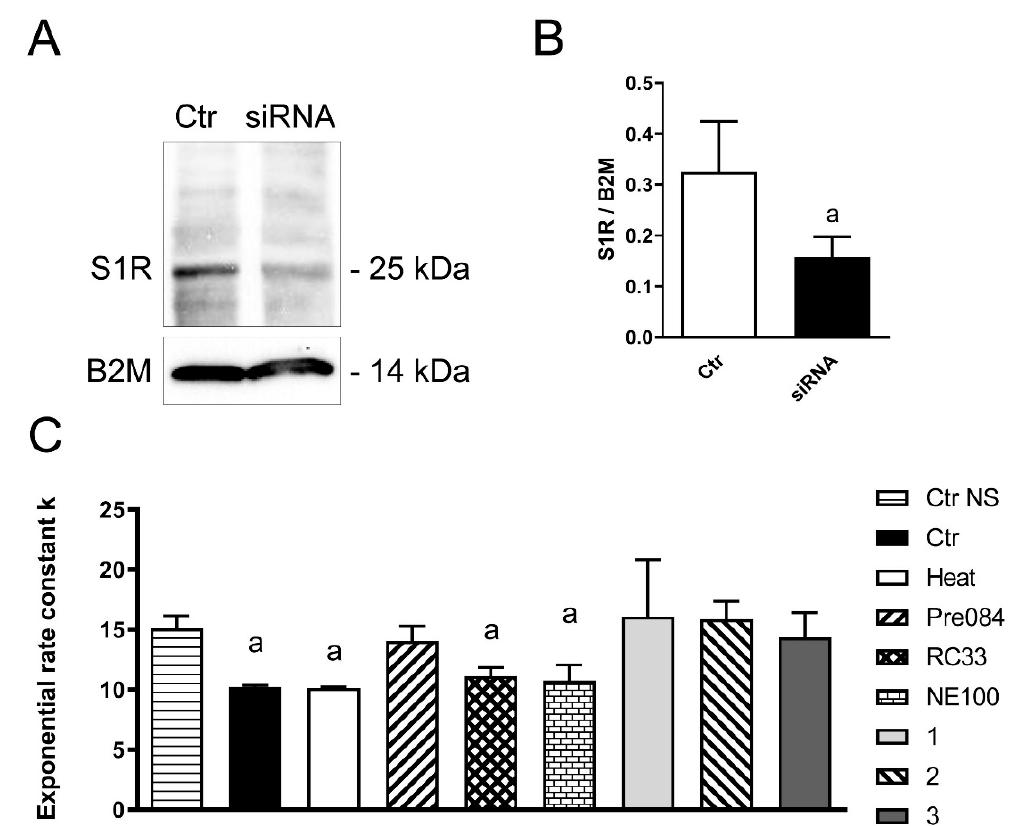
Figure 7. Effect of compounds Pre084, RC33, NE100, 1 – 3 on the water permeability of S1R silenced HeLa cells in heat-stress condition. ( A ) HeLa cells were silenced and the effectiveness in silencing was tested by immunoblotting. A representative blot is shown. 30 µ g of proteins were loaded and the blots incubated with anti-S1R antibody. Blots were stripped and re-probed with anti β -2-microglobulin (B2M) antibody. Bands of 25 and 14 kDa were obtained for S1R and B2M, respectively. ( B ) Densitometry was performed by acquiring the blot with the iBright CL1000 imaging system. Semiquantitation was performed by iBA (iBright Analysis Software) and the results were normalized to the corresponding B2M. A significant reduced protein expression in silenced (siRNA) cells compared to controls (scrambled; Ctr) was observed (a, p < 0.001; Student’s t test). ( C ) Effect of S1R agonist treatment on the water permeability of S1R-KD HeLa cells heat-stressed (Heat). The compounds were used at 20 µ M final concentration. Ctr NS, control HeLa cells Not Silenced; Ctr, control, untreated HeLa cells silenced for S1R. Values are means ± SD of 4–15 single shots (time course curves) for each of 4–6 different experiments. a, p < 0.05 vs. Ctr NS, Pre084, 1 , 2 , 3 (ANOVA, followed by Newman-Keuls’s Q test).